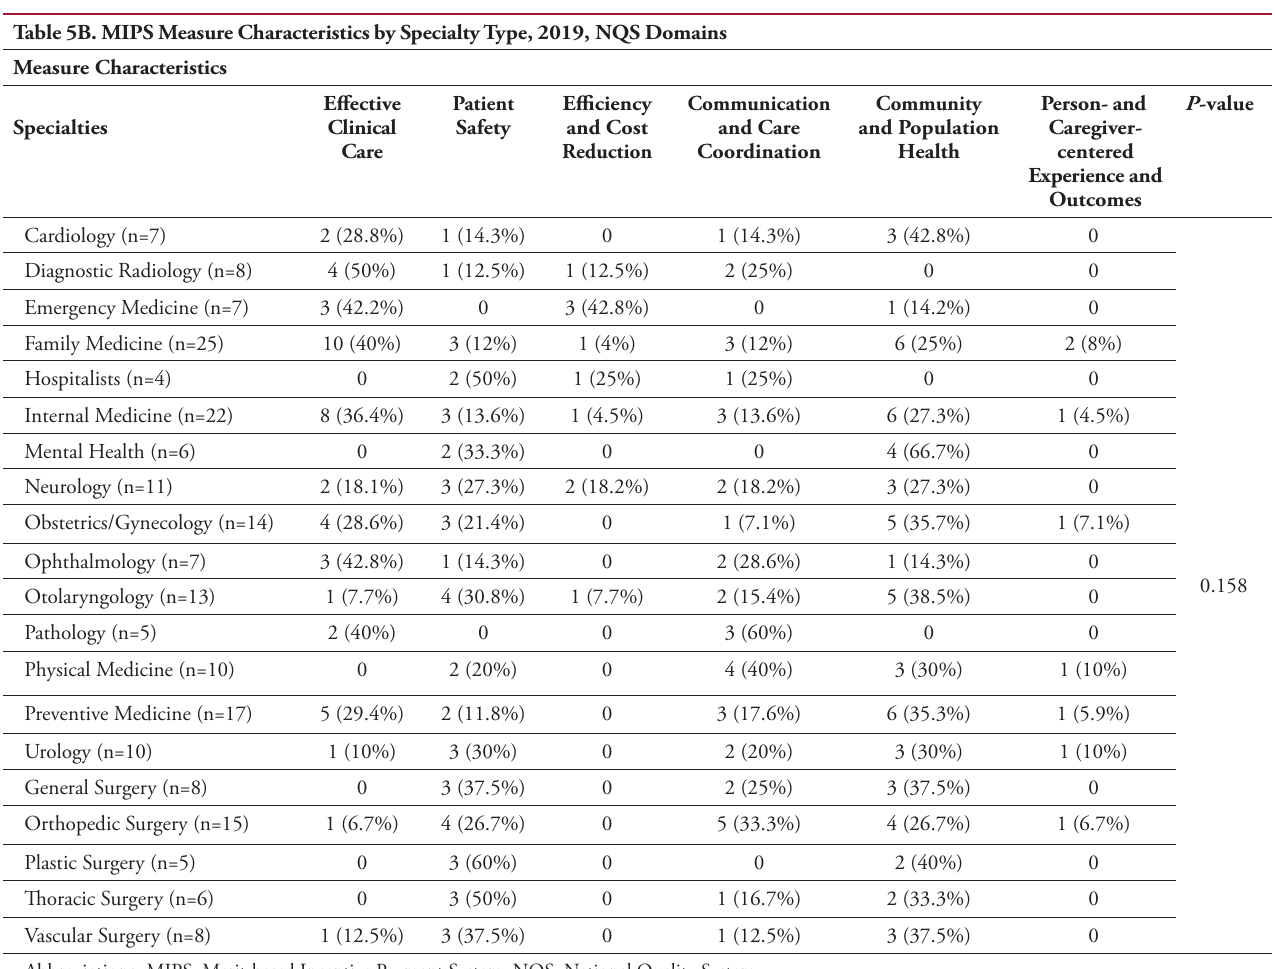
Table 5B. MIPS Measure Characteristics by Specialty Type, 2019, NQS Domains Measure